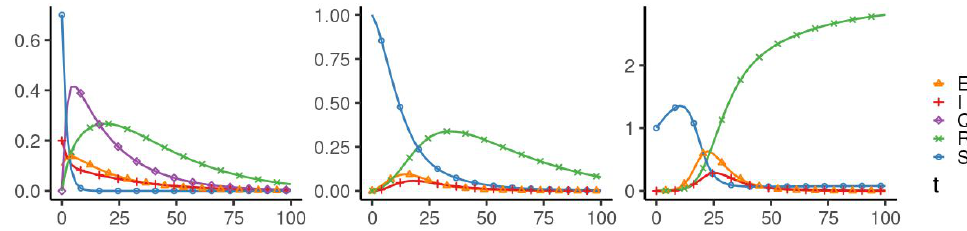
Figure 12. Experiment 2. Spread of the virus in three different clusters in the controlled case. Figure 13 represents the structure of the optimal treatment policies u i ( t ) , i = 1, 2, 3.